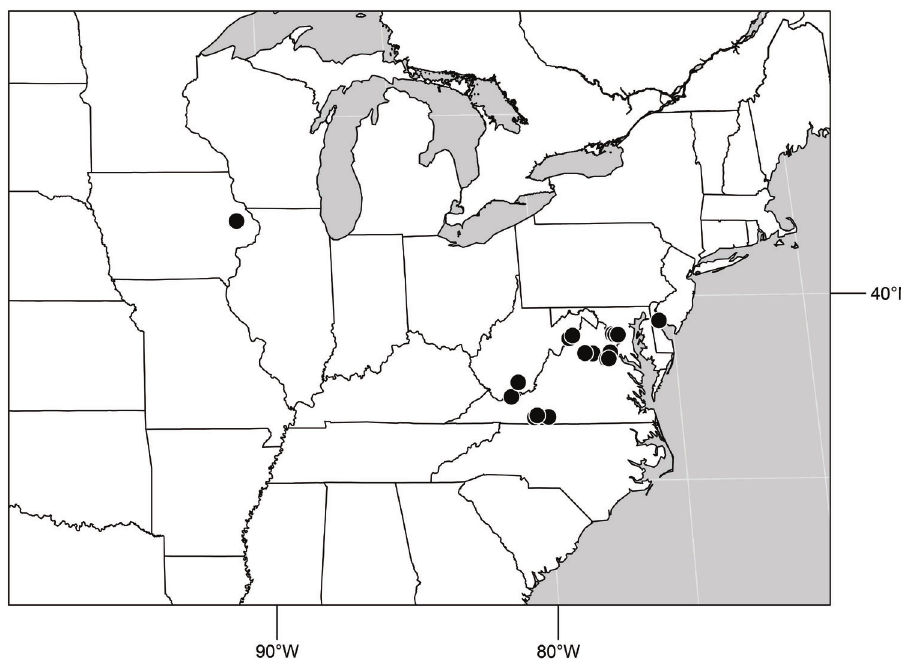
Figure 148. Distribution of Hydrochasma aquia Mathis and Zatwarnicki